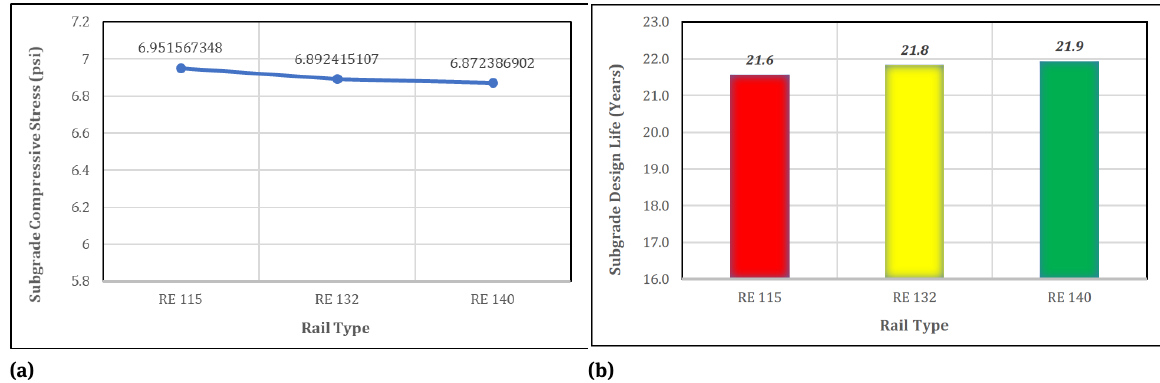
Figure 10: Effect of rail type on subgrade compressive stress (a) and on subgrade design life (b) in asphaltic overlayment track.